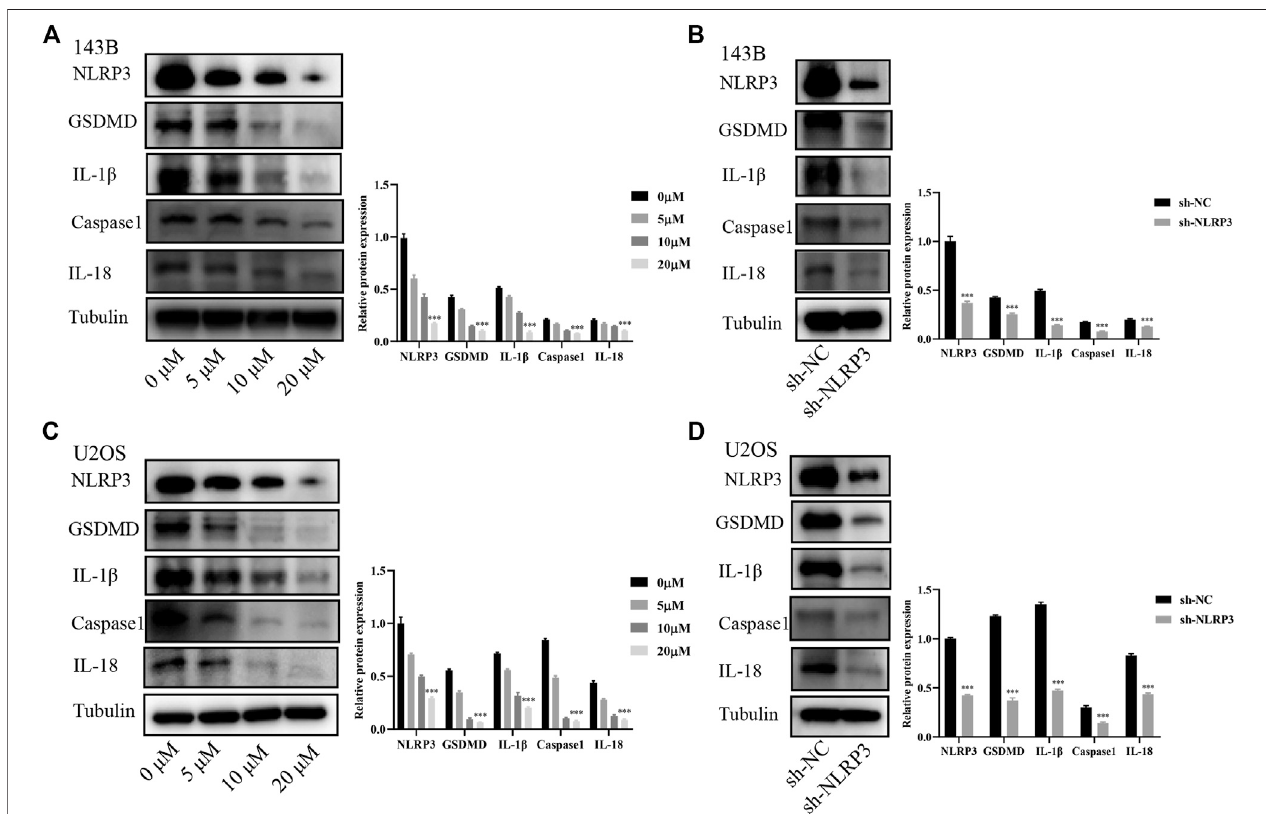
FIGURE6| Involvement oftheNLRP3/caspase-1/GSDMD pathway intheeffect ofNLRP3on osteosarcoma. Expressions ofNLRP3/caspase-1/GSDMD and the relatedproteins IL-1 β and IL-18 in 143Bcells treated with CY-09 (A) or lentivirus infection (B) Expressions ofNLRP3,caspase-1, GSDMD and the related proteins IL-1 β and IL-18 in U2OS cells treated with CY-09 (C) or lentivirus infection (D) The protein levels were measured in triplicate.